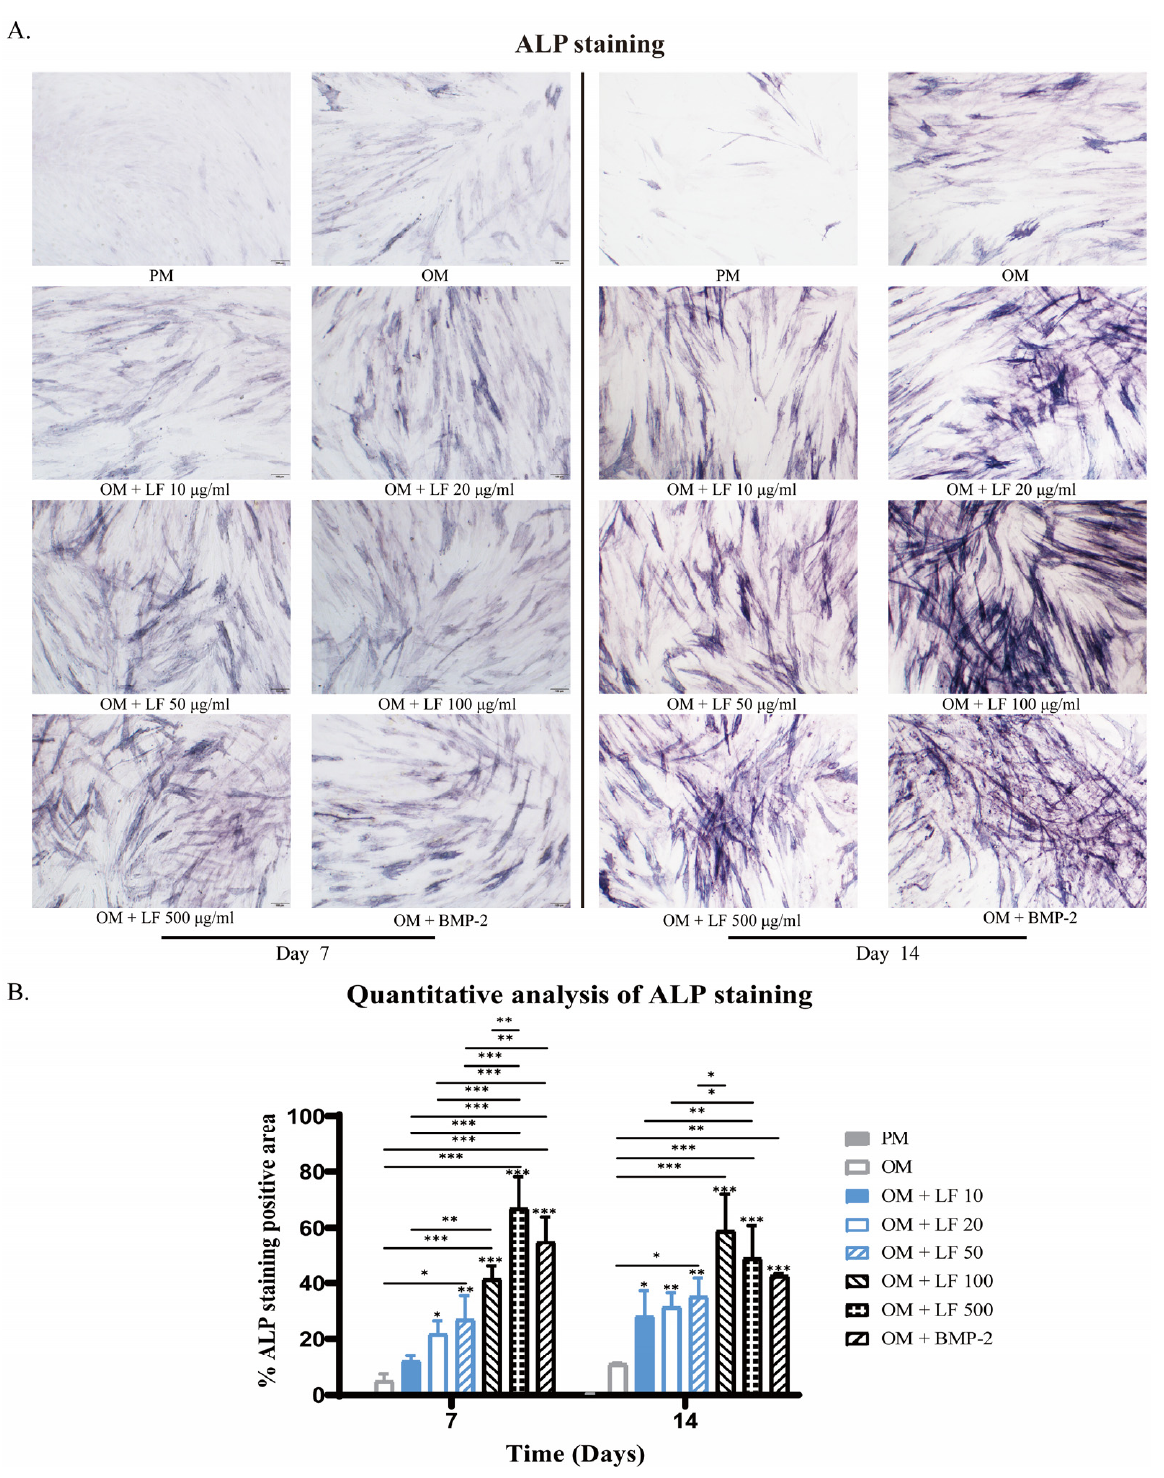
Figure 2. ALP staining of ADSCs on days 7 and 14 of osteogenic differentiation, photographed at 10× magnification under a light microscope. ( A ) ALP staining of hADSCs after treatment with LF or BMP-2. ( B ) Quantitative analysis of ALP staining. On the top of each column without a capped line, significance levels of seven OM groups are compared with that of PM group (* p < 0.05, ** p < 0.01, and *** p < 0.001).